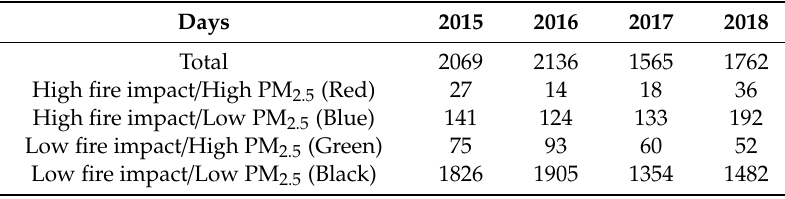
Table 3. Number of points for each quadrant in Figure